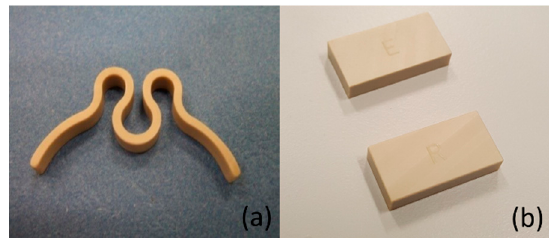
Figure 1. ( a ) Spring-type clip component of a medical device and ( b ) fabricated test specimens for hardness and differential scanning calorimetry (DSC)